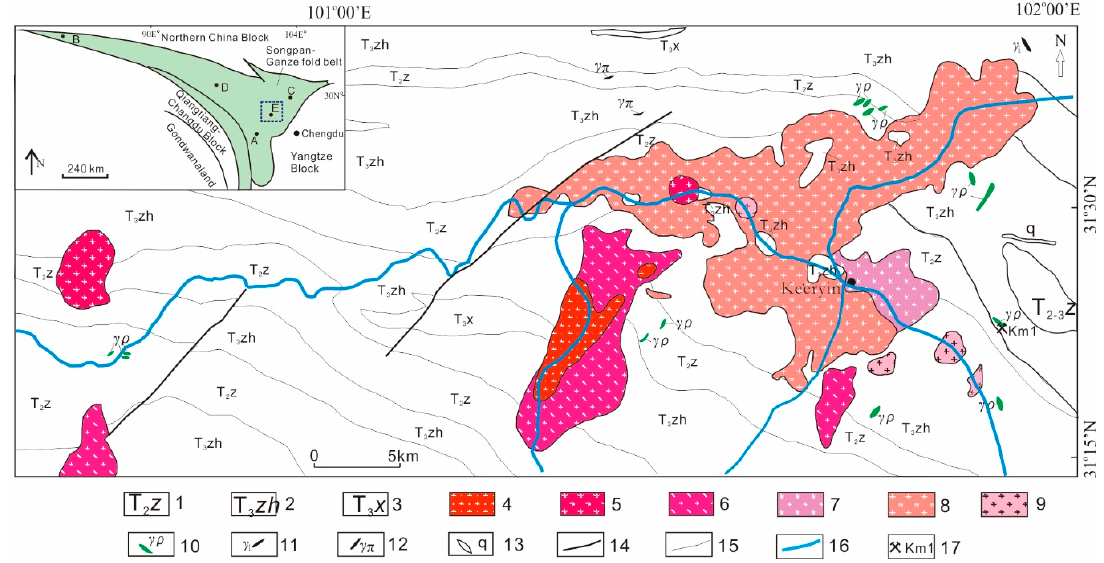
Figure 6. Geological map of the Ke’eryin rare metal deposit in Sichuan Province, China. 1: Quartz sandstone and slate of the Middle Triassic Zaguniao Formation; 2: Sandstone of the Upper Triassic Zhuwo Formation; 3: Sericite slate of the Upper Triassic Xindu Formation; 4: Quartz diorite; 5: Biotite